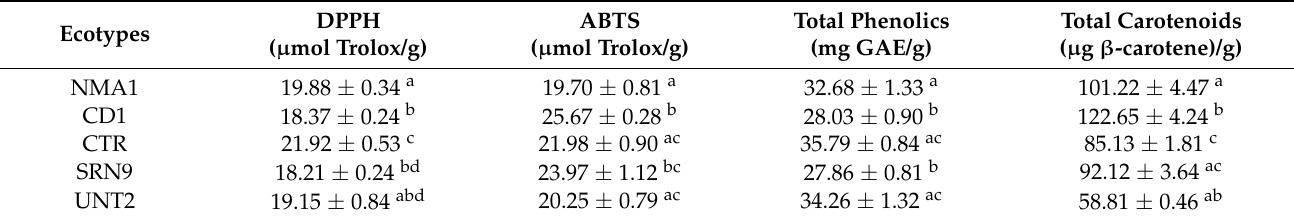
Each value represents the means ± SEM of three replicates, n = 3, while different letters on the same column indicate significant difference using Tukey test at 0.05 level of significance ( p <